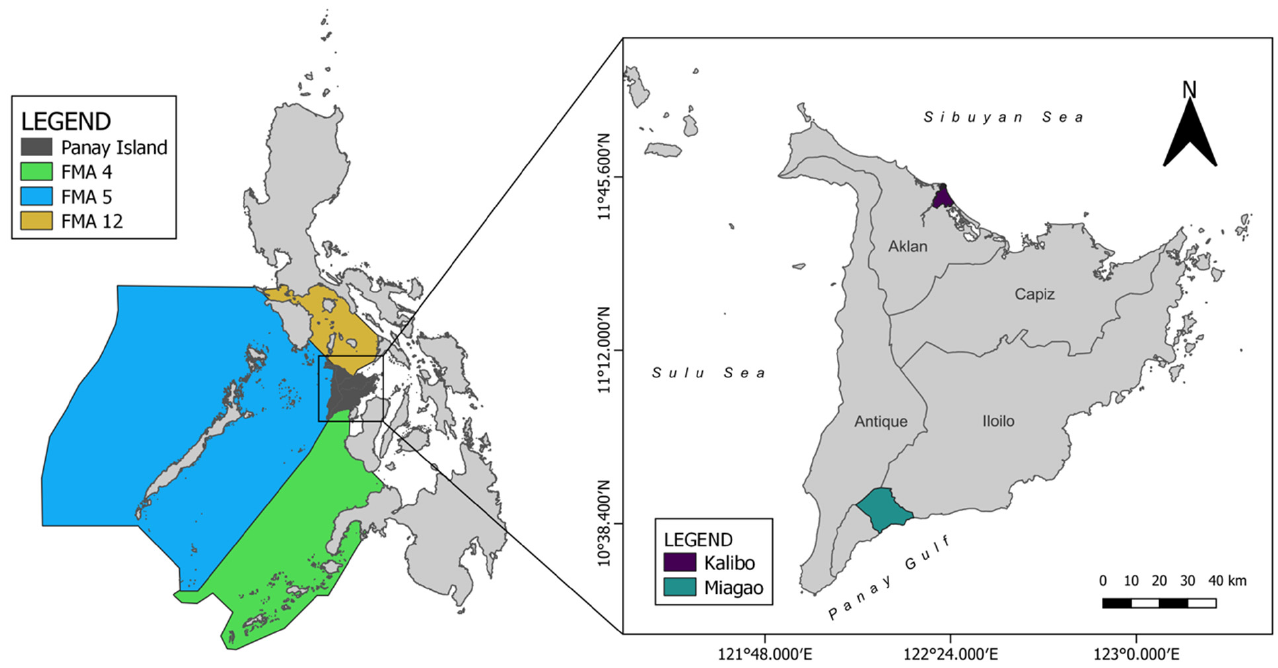
Figure 1. Map showing Panay Island, Philippines, the extent of surrounding Fisheries Management Areas (FMAs) (4: Panay Gulf—part of Sulu Sea, 5: Sulu Sea, and 12: Sibuyan Sea), and location of the commercial fish landing sites in Miagao, Iloilo and Kalibo, Aklan.